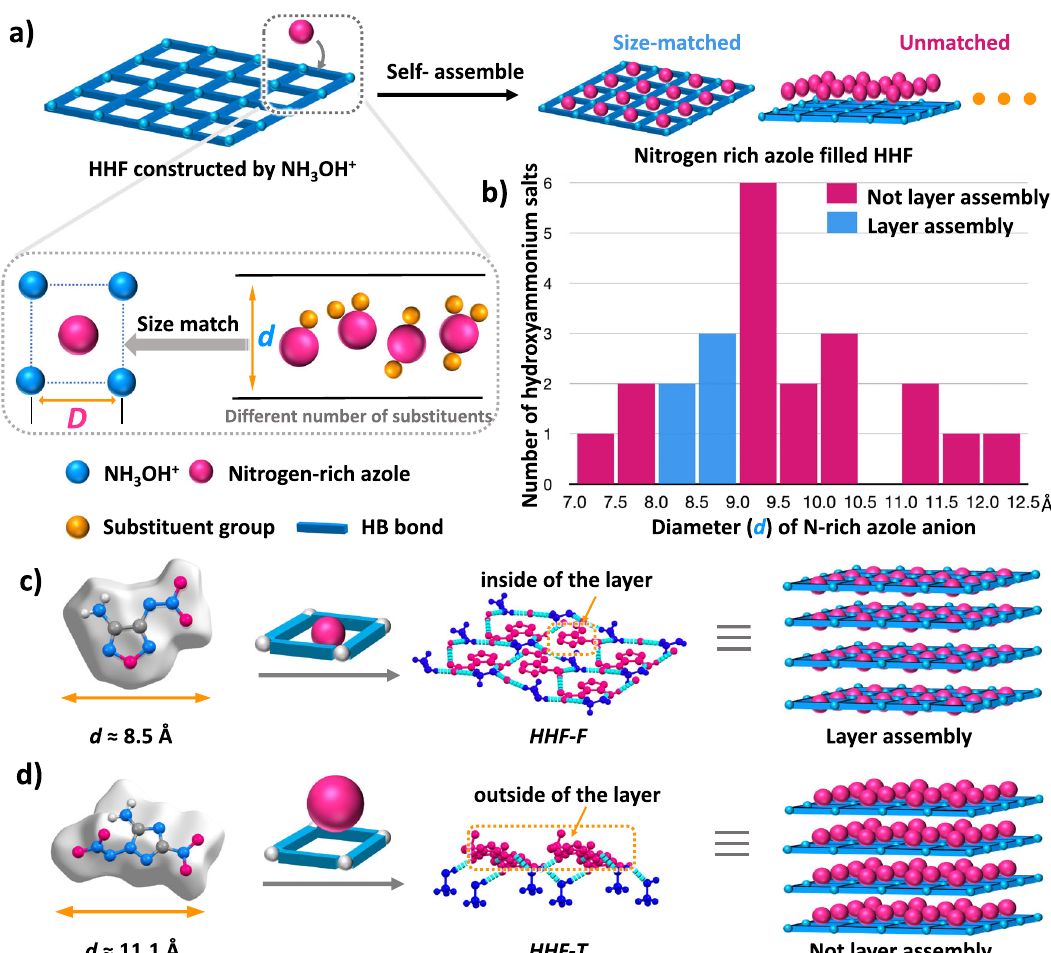
Fig. 2 | Construction of hydrogen bonded hydroxylammonium framework. a Illustration of possible size-matched between hydrogen bonded hydro- xylammonium framework and nitroamine N-rich azoles. b The diameter for N-rich azole anion of energetic hydroxylammonium salts (23 hits from Cambridge